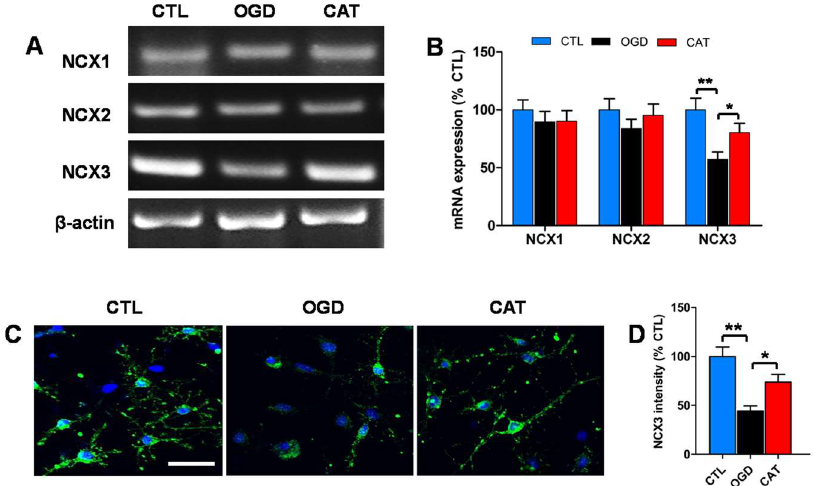
Figure 4. Effects of catalpol on Na + /Ca 2+ exchanger 3 ( NCX3 ) expression in PreOLs under OGD. ( A ) RT-PCR to probe Na + /Ca 2+ exchanger 1 ( NCX1 ), Na + /Ca 2+ exchanger 2 ( NCX2 ), and NCX3 mRNA levels in the CTL, OGD, and CAT groups. β-actin was used as control. ( B ) Quantification of NCX1 , NCX2 , and NCX3 mRNA levels from the RT-PCR analyses. ( C ) Representative NCX3 staining (green) in the CTL, OGD, and CAT groups. Cell nuclei were counterstained with DAPI (blue). Bar = 25 μm. ( D ) Quantification of the optical density of NCX3 staining in the CTL, OGD, and CAT groups. Data